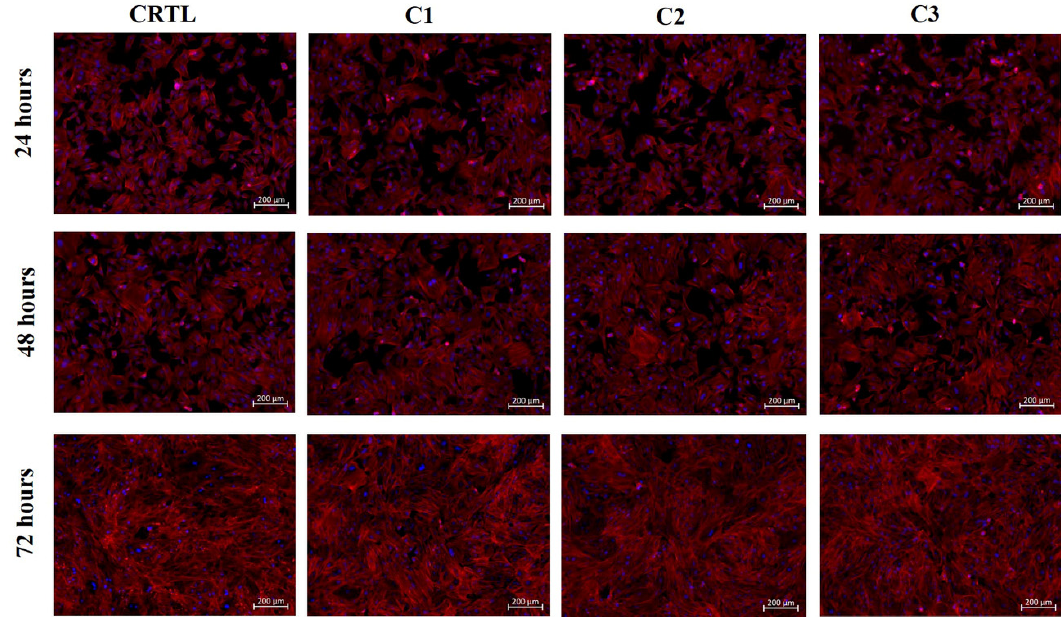
Figure 7. Fluorescence microscopy images of chondrogenic primary cells cultured in the presence of CRTL (RPMI medium) and Ty–GG/SF hydrogels made in different conditions (C1, C2 and C3) for 72 h. Chondrogenic primary cells were incubated with C1, C2 and C3 of Ty–GG / SF hydrogels. It was possible to see that all conditions presented the typical morphology of chondrogenic primary cells, blue (nuclei) and red (cytoskeleton), suggesting healthy proliferation and survival when compared with